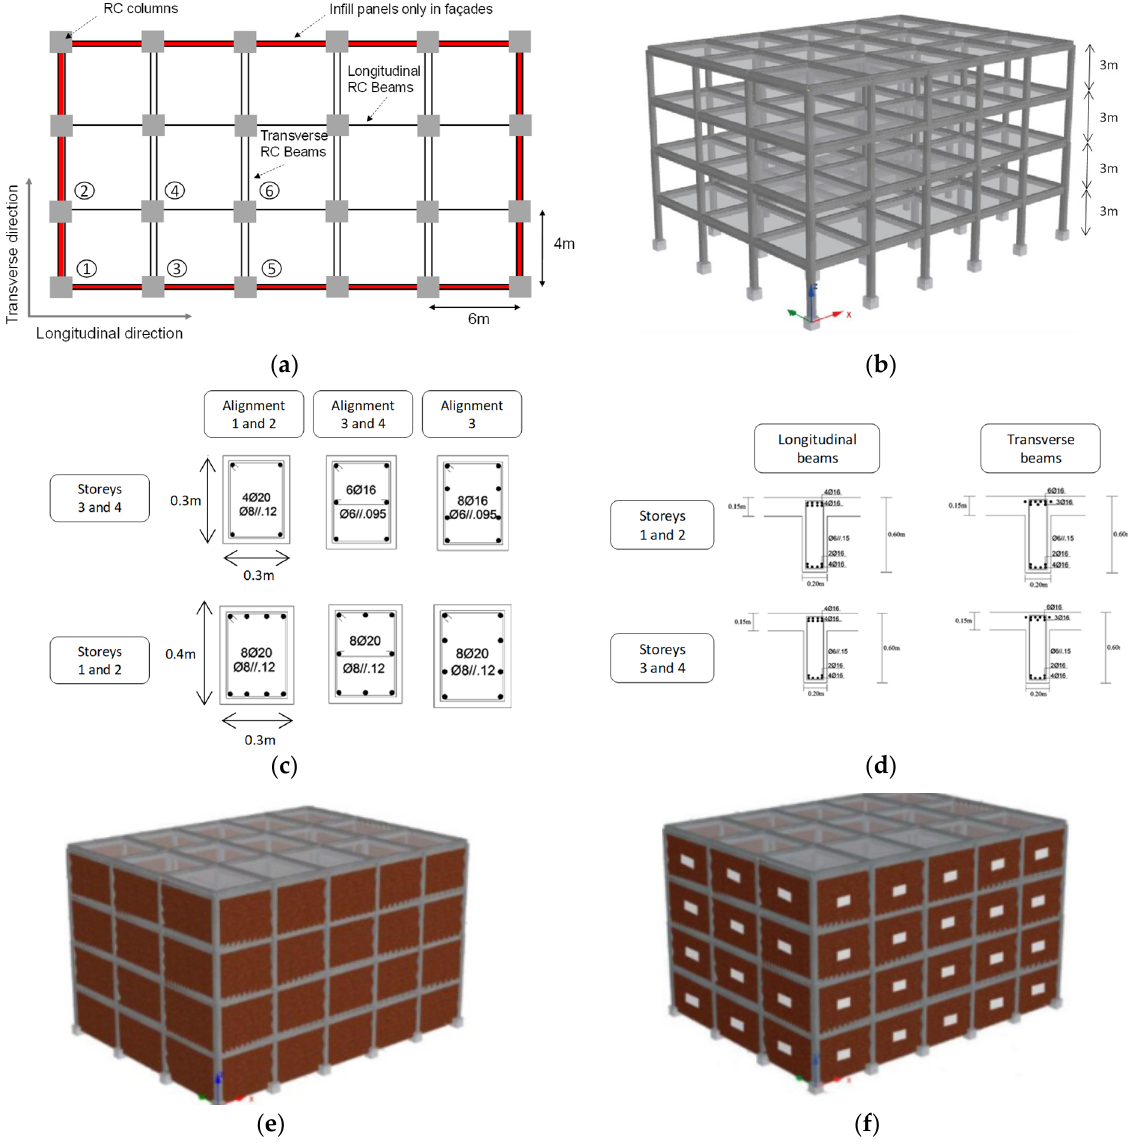
Figure 6. Case study: ( a ) plan view; and ( b ) general view of the BF model; ( c ) columns’ cross-section; ( d ) beams’ cross-section; ( e ) FI model; and ( f ) PI model.